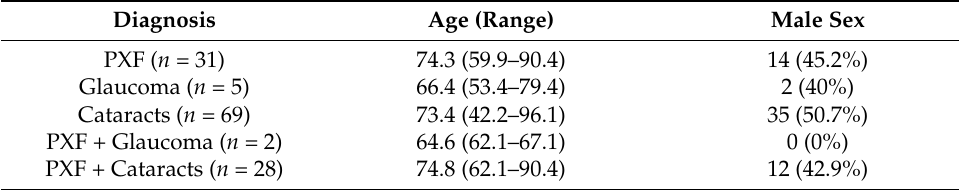
Table 2. Age and sex of PXF, cataracts and glaucoma